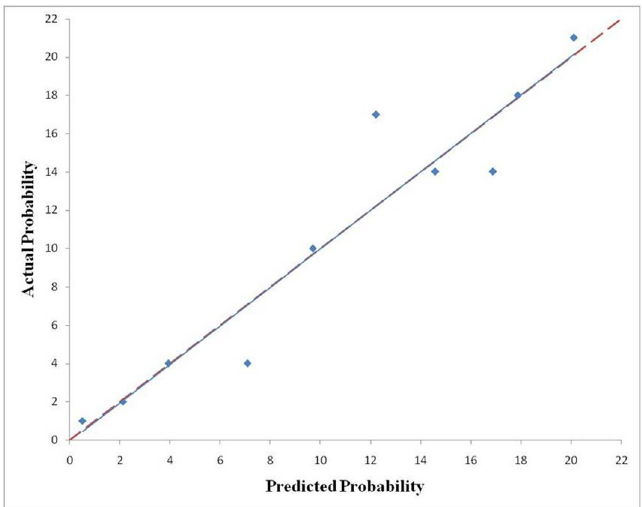
Figure 5. Calibration curves of the nomogram for predicting invasive pulmonary adenocarcinoma lesions from the training cohort. The Hosmer–Lemeshow test had a p value of 0.202 in the training